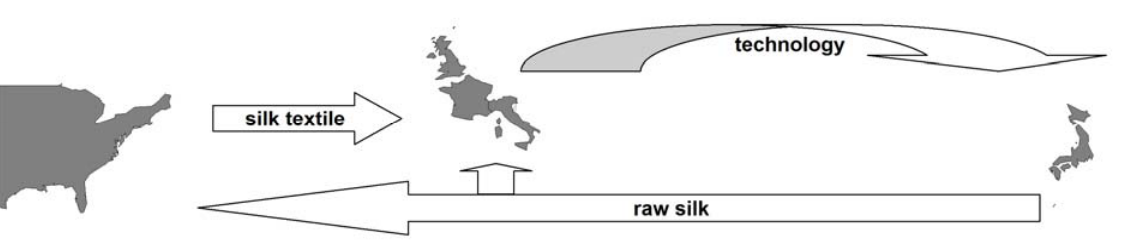
Figure 1. Japan in the Global Silk Trade,